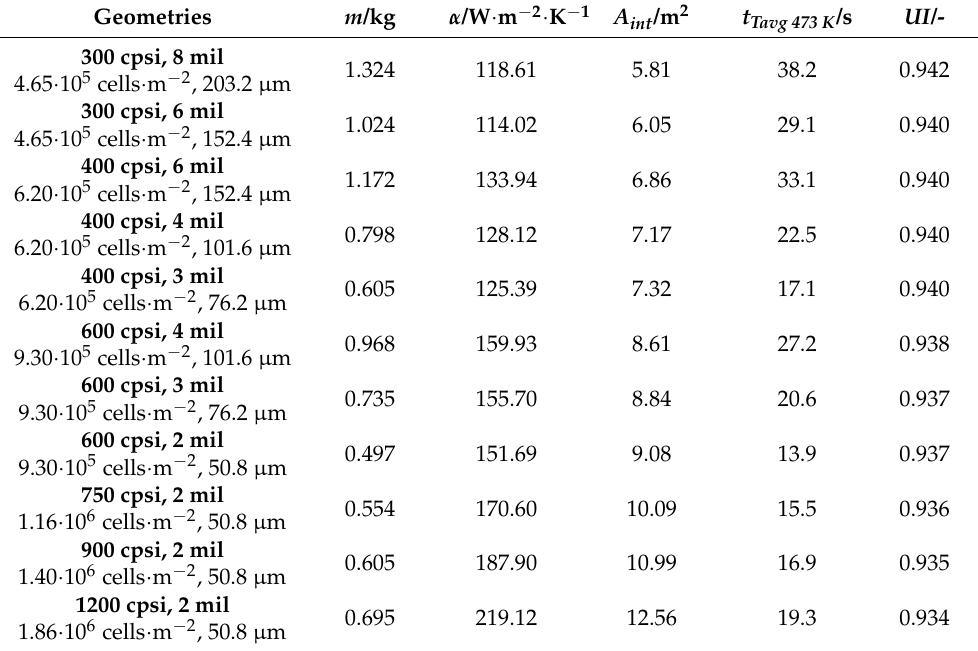
Table 2. Overview of relevant parameter for heat-up at a flow rate of 100 kg/h and 523 K. Geometries